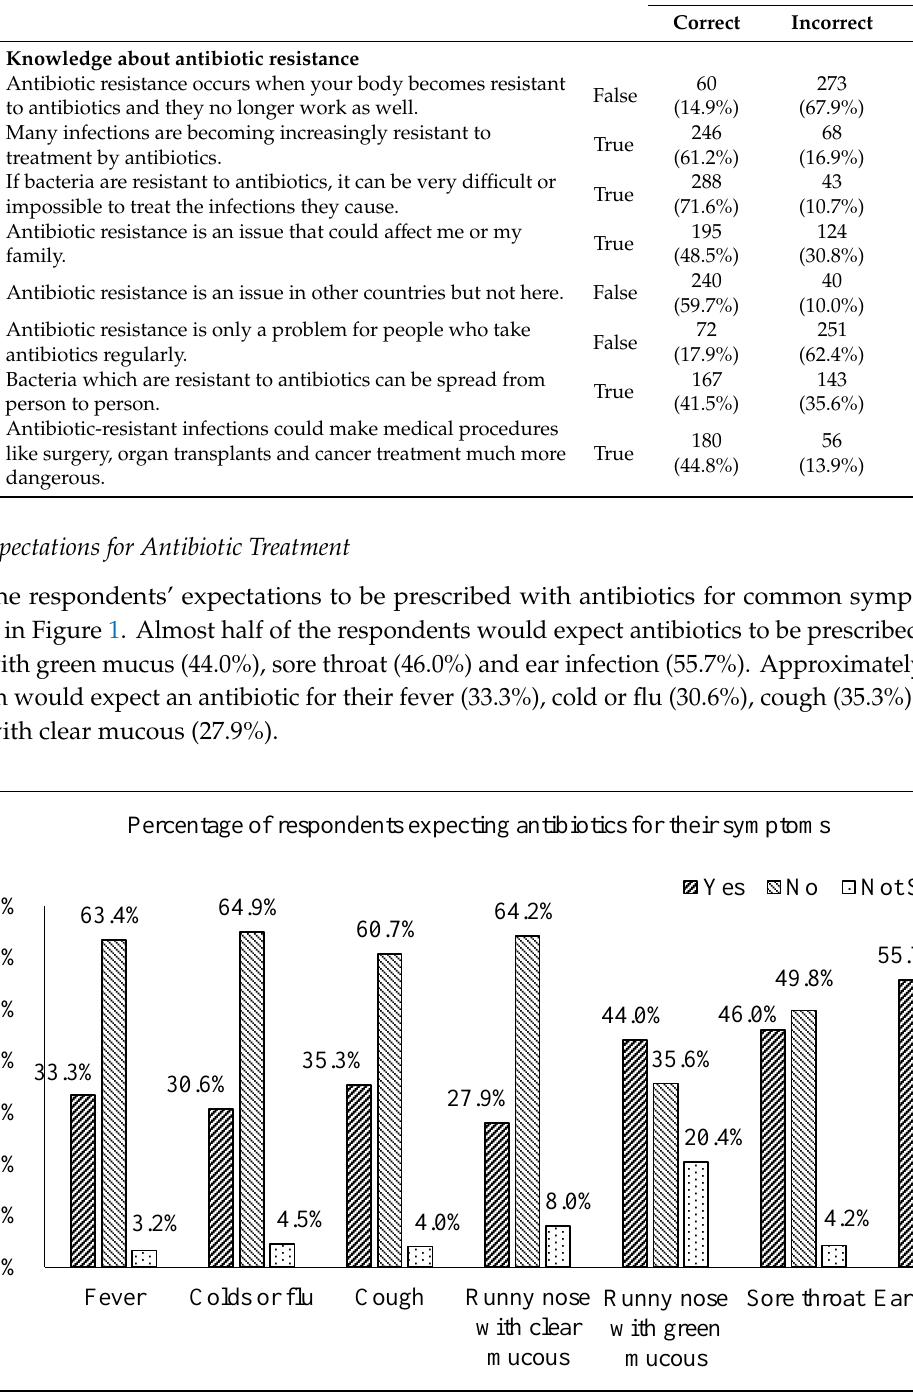
Figure 1. Percentage of respondents who expected antibiotics to be prescribed for the listed common symptoms (n = 402).